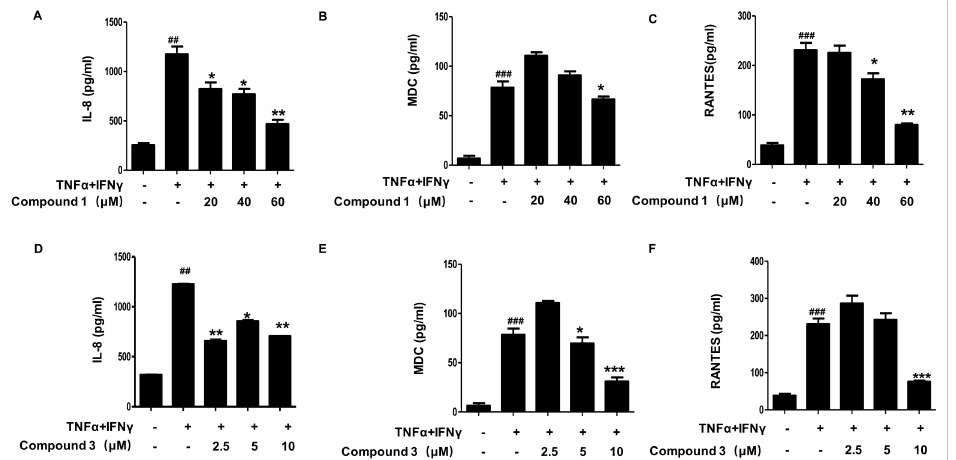
Figure 4. Effects of compounds 1 and 3 on IL-8 ( A , D ), MDC ( B , E ), and RANTES ( C , F ) secretion in TNF- α /IFN- γ -stimulated HaCaT cellsThe levels of IL-8, MDC, and RANTES were measured using the culture supernatant of TNF- α /IFN- γ -stimulated HaCaT cells. The cells were pretreated with the indicated concentrations of compounds 1 and 3 for 3 h (+) or not (-), and then stimulated with TNF- α /IFN- γ (+) for 24 h. Data are represented as the mean ± SD of three independent experiments., ## p < 0.01, ### p < 0.001 vs. control. * p < 0.05, ** p < 0.01, *** p < 0.001 vs. TNF- α /IFN- γ -treated